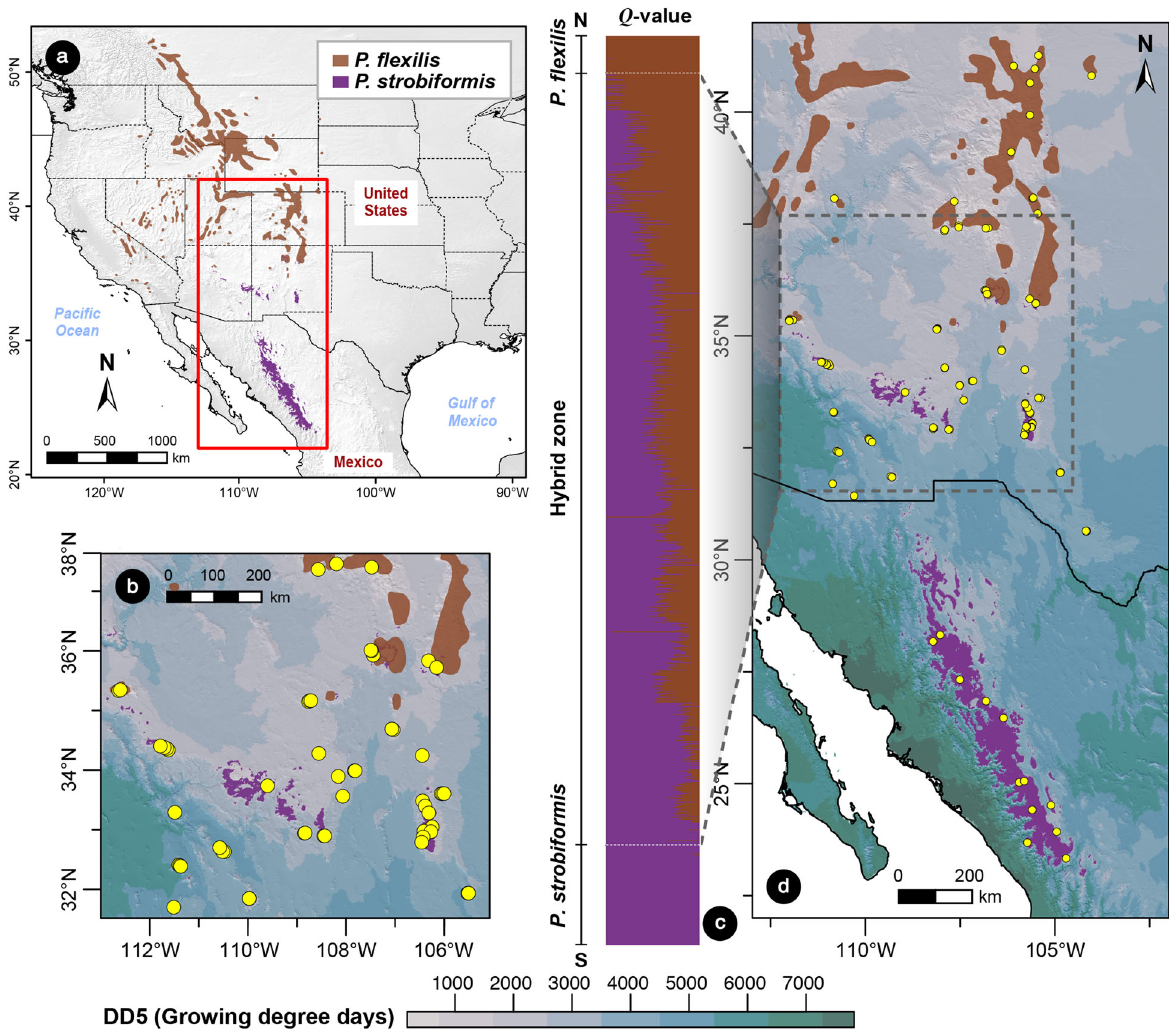
Fig. 1 Geographic extent of the assayed populations and ancestry proportion of individual trees along a latitudinal gradient. a Geographic range of P. strobiformis (purple) and P. fl exilis (brown) on the elevational political map of North-America, with the study region highlighted by a rectangular box. Range maps were obtained from ref. 103 for P. strobiformis and from ref. 104 for P. fl exilis . Background elevational map in grey was generated using the raster layer from ClimateWNA. b Fine-scale representation of the 98 hybrid populations used in this study. c STRUCTURE plot showing change in per individual tree ’ s genomic ancestry along latitude at K = 2 for 1122 trees. d Geographical distribution of Pinus fl exilis and P. strobiformis with sampled populations indicated in yellow. The background colour palette in b and d represents a raster map of degree days above 5 °C (DD5) obtained from ClimateWNA, highlighting one of the environmental gradients of adaptive